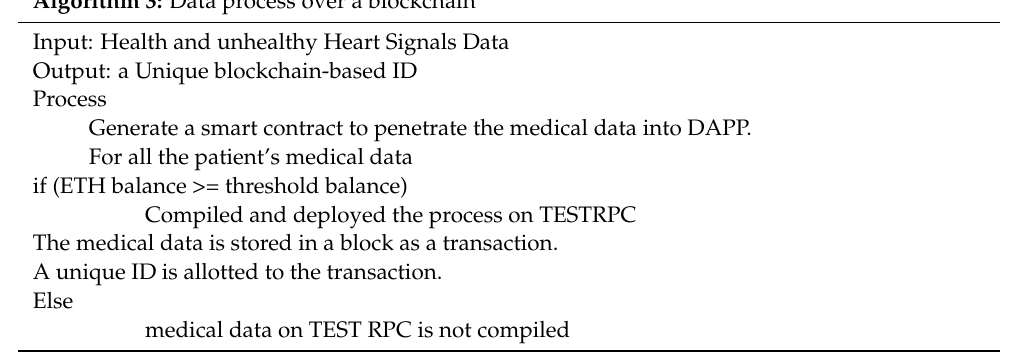
Algorithm 3: Data process over a